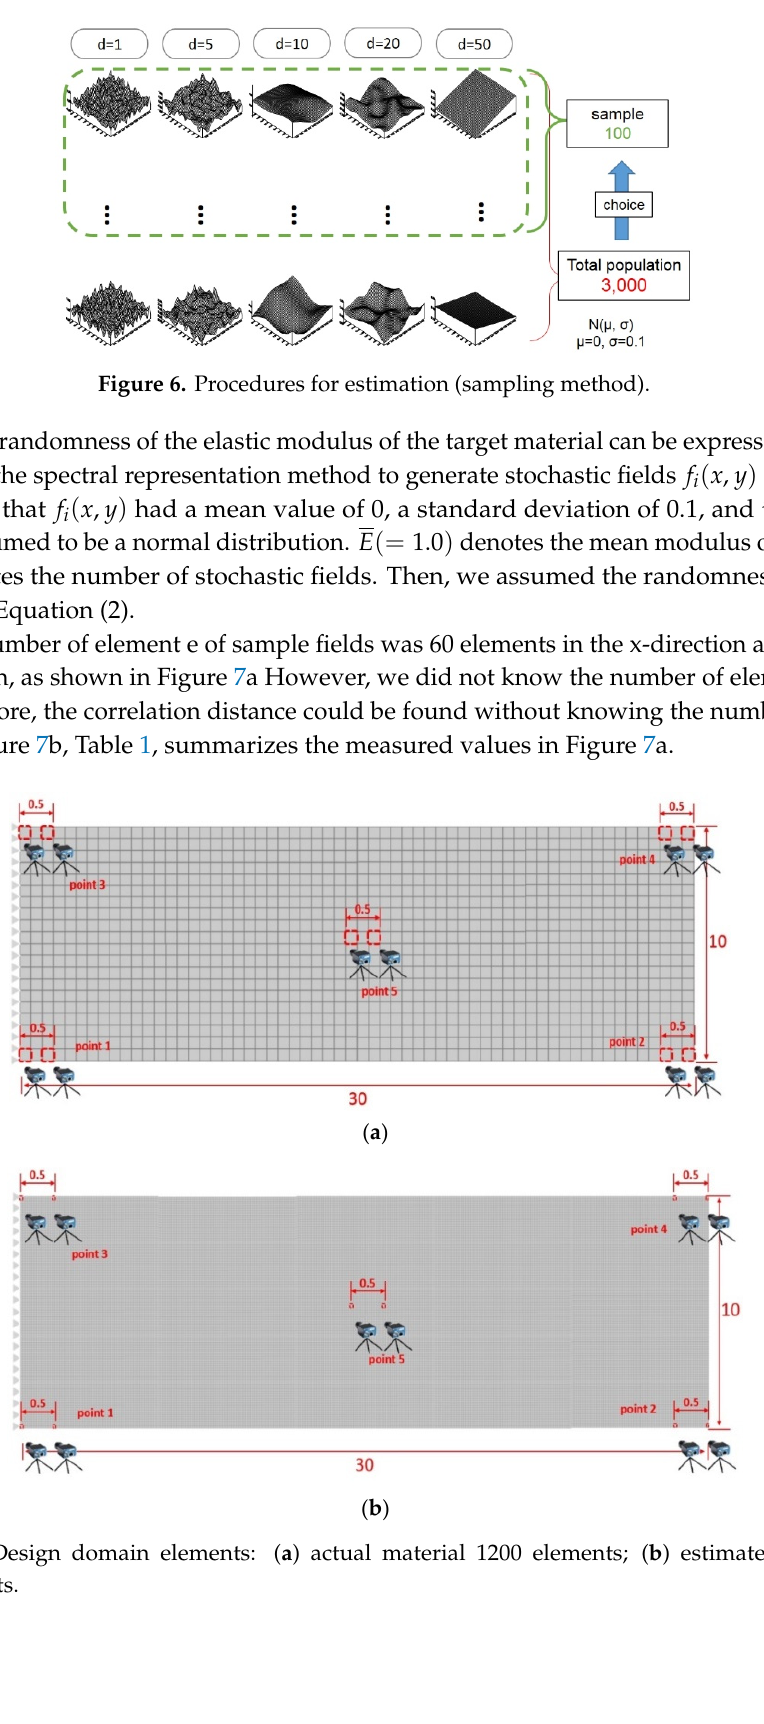
Figure 7. Design domain elements: ( a ) actual material 1200 elements; ( b ) estimated material 6000 elements. Table 1. Observation data at the distance (= 0.5) per correlation distance.